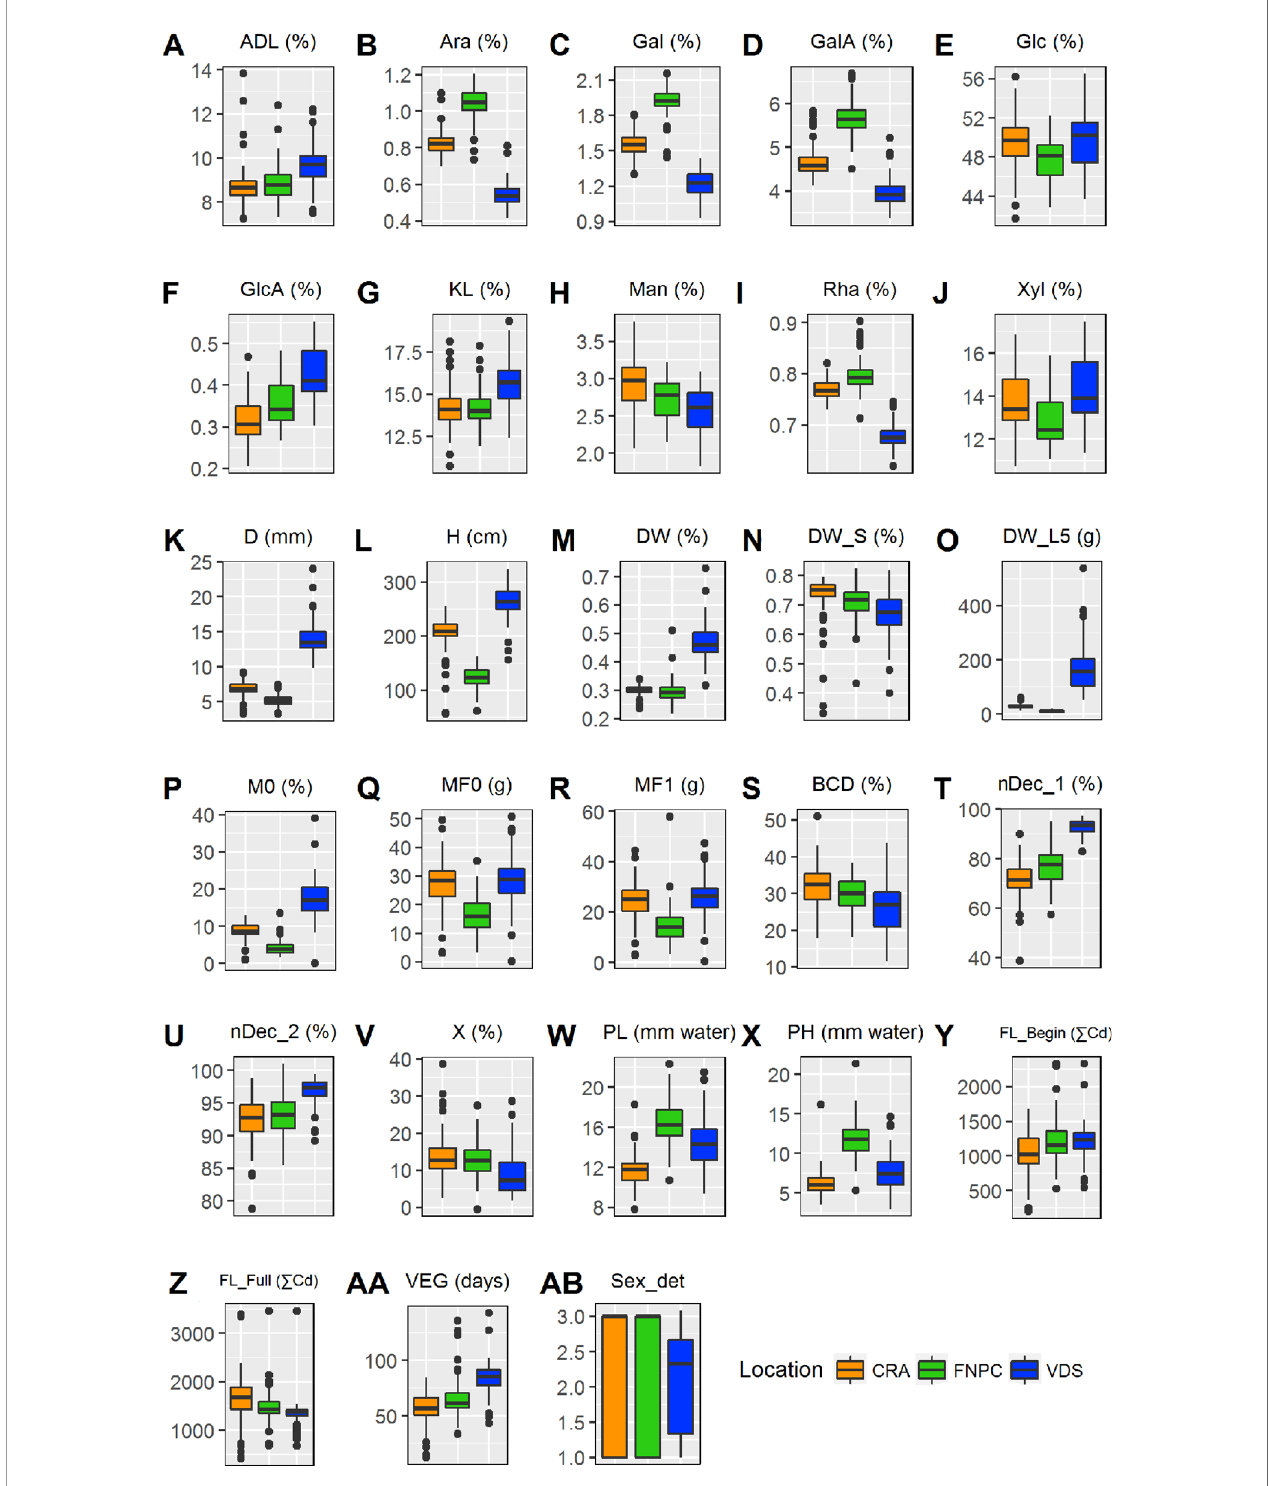
FIGURE 1 | Box plots summarizing the variation of a hemp panel for 28 diverse traits in three locations with contrasting environments. For every box plot, the horizontal line represents the median of the trait, the box represent the interquartile range, the bars outside the box represent the extremes and the crosses indicate the outliers. In every panel, the x-axis indicates the location, as speci fi ed in the legend. Range of statistical differences across locations are available in Supplementary Table 3 . See Table 3 for abbreviations. Sex_det stands for Sex